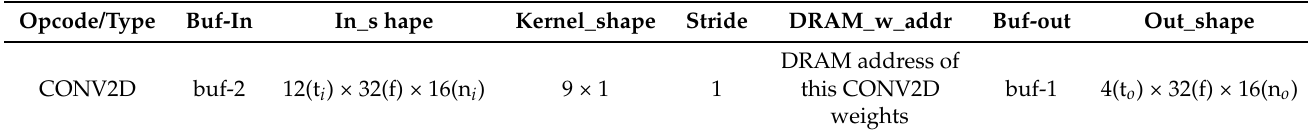
Table 6. Parameters of an example CONV2D operation in Figure